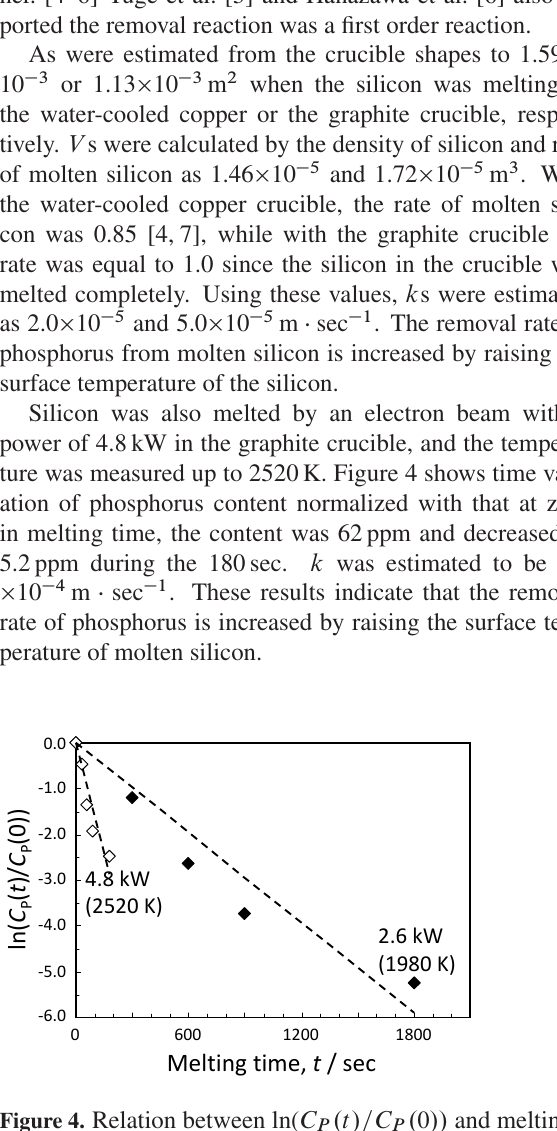
Figure 4. Relation between ln( C P .t/=C P .0// and melting time by 2.6 and 4.8 kW electron beam in graphite